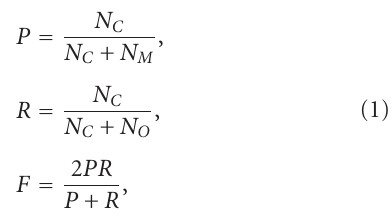
a date input, a time line, and a drawing of the house